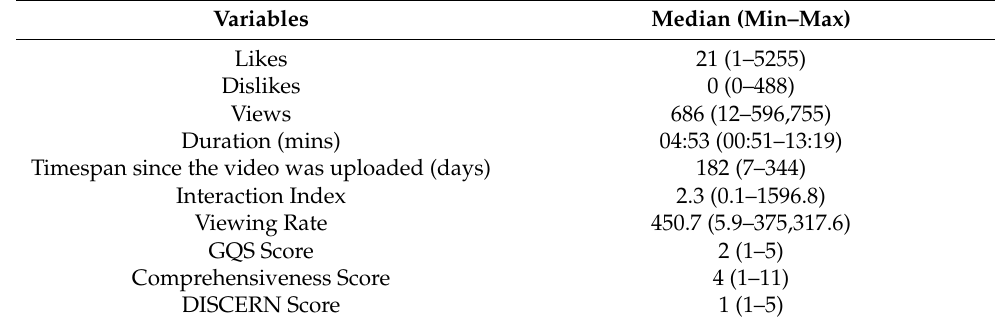
Table 1. Characteristics of research videos.